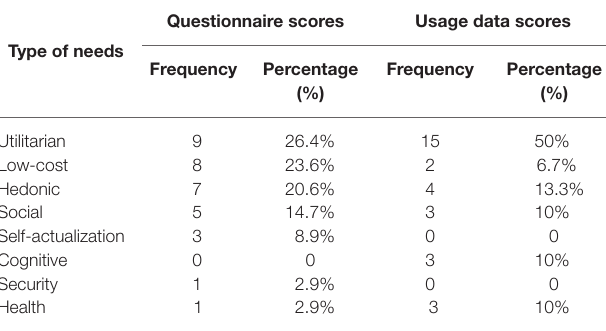
TABLE 7 | Descriptive statistics for primary needs of the participants (the needs ranked first).